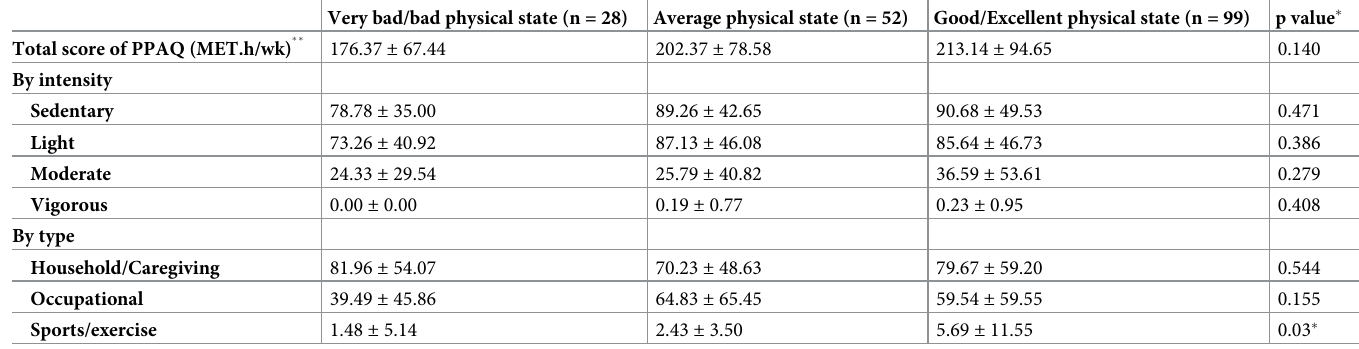
Table 5. Type and intensity of PA, deducted from the PPAQ, in women categorized depending on their subjective perception of physical well-being (N = 179). Very bad/bad physical state (n = 28) Average physical state (n = 52) Good/Excellent physical state (n = 99) p value � Total score of PPAQ (MET.h/wk)